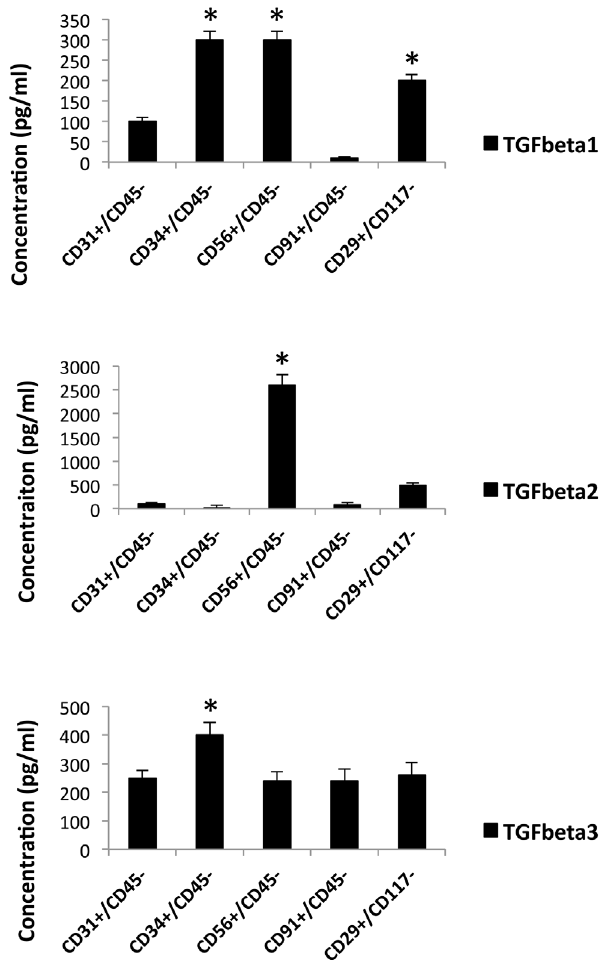
Fig. 7. Inflammatory cytokine secretion of CD29, CD31, CD34, CD56 and CD91 positive cells. Flourescent-conjugated antibodies to CD29, CD31, CD34, CD56 and CD91 were used to separately sort and subculture cells form collagenase 2 digested human muscle tissue. The cells were cultured to confluence and the supernatants were removed and assessed for TGFß1, TGFß2 and TGFß3 levels by ELISA. The graph indicates the concentrations of the cytokines (mean ¡ SEM, n 5 8). A significant difference in amounts (mean pg/ml) is noted (*) between CD34, CD56 and CD29 for TGFß1, CD56 for TGFß2 and CD34 for TGFß3 when compared to the other populations (Mann-Whitney U Test, p #